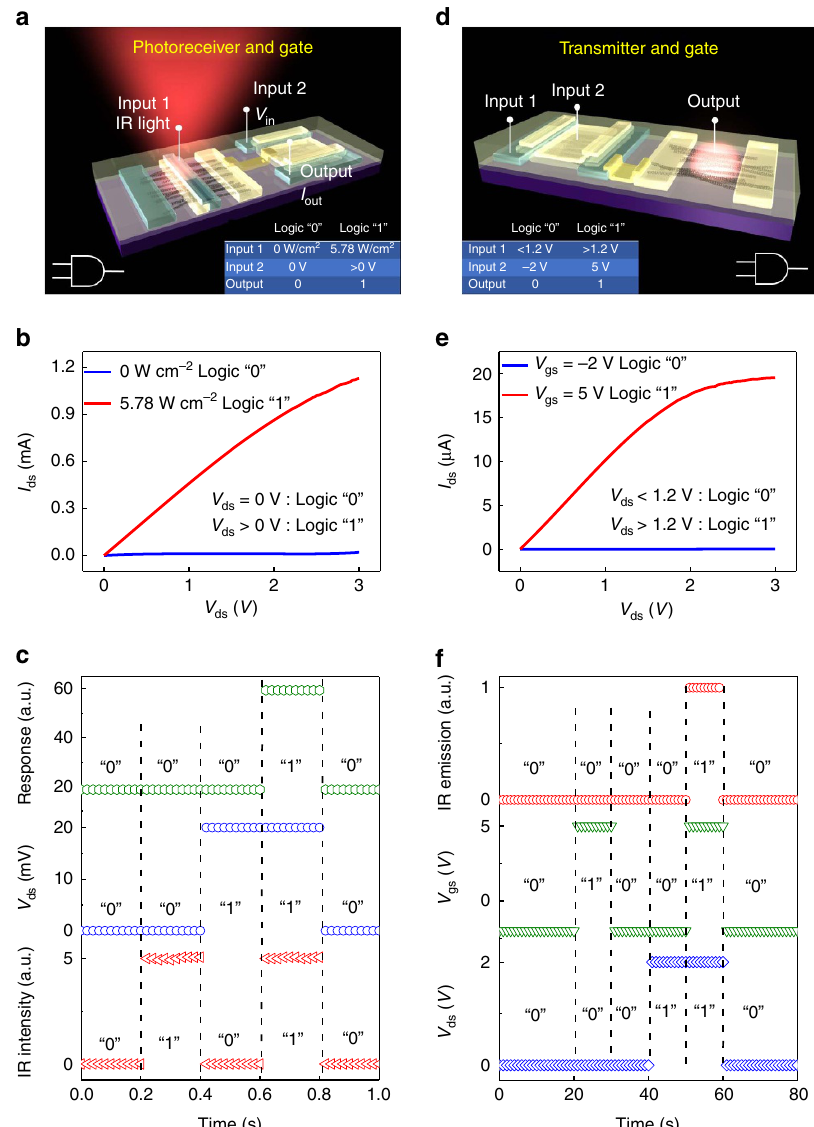
Figure 3 | Heterogeneous optoelectronic logic gate. ( a ) The AND gate realized via a photovoltaic receiver with optical or electrical inputs and output. The left inset is the equivalent circuit. The right inset is the truth table defining the logic 0 and 1 states for both the input and output, as determined by the output characteristics shown in b . ( c ) Waveform of the AND gate. ( d ) The AND gate realized via a transmitter with electrical inputs and optical output. The left inset is the truth table corresponding to the output characteristics shown in e . The right inset is the equivalent circuit. ( f ) Waveform of the AND transmission of data between functional layers. As shown in Fig. 4a, two CNT emitter channels and a two-cell cascading detector are vertically integrated with a 20-nm HfO 2 layer in between to provide electrical isolation (corresponding side-view was shown in the inset of Fig. 4e). The real system used in this work is somewhat more complex, with a nine-channel interdigital emitter in the top layer and a well aligned nine-cell cascading detector in the bottom layer (Fig. 4b, corresponding alignment process is discussed in Supplementary Note 6 and shown in Supplementary Fig. 5). The top-layer emitter is based on chirality-selected (8, 3) and (8, 4) CNTs, and the bottom-layer detector is fabricated using high-semiconducting-purity CNTs. Typical EL spectra obtained from the top-layer emitter at various biases (Fig. 4c) indicate that the emission of the top-layer emitter falls between the E 11 and E 22 absorption peaks of the bottom-layer detector (Supplementary Fig. 6b), making the